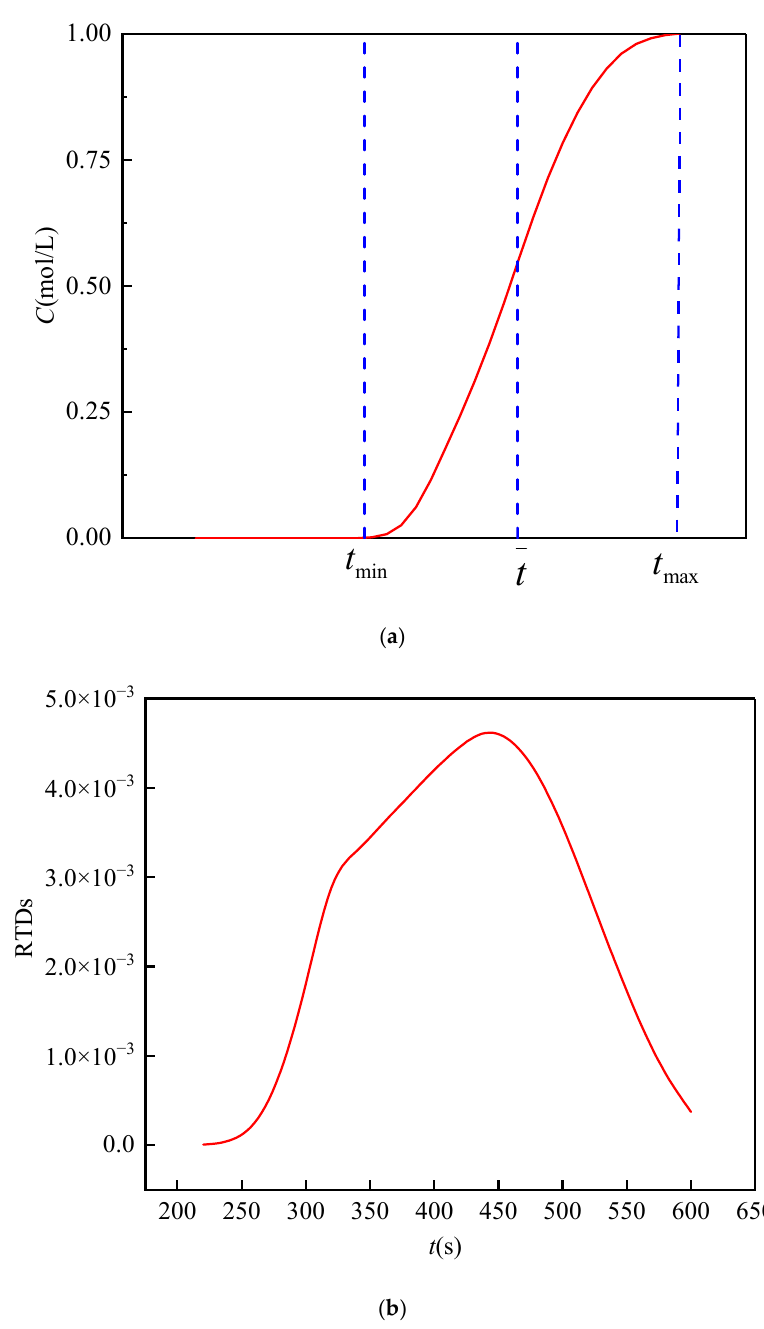
Figure 5. ( a ) The breakthrough curve; ( b ) the residence time distribution curve. The time variance s 2 and time skewness sk t of the residence time distribution curve is calculated on the basis of average Figure 6 shows the breakthrough curve and average time of the solute transport from different fractal dimensions and the standard deviation of aperture. The average arrival time of solute transport increases with the growth of the fractal dimension and standard deviation of aperture. This is because the increase in fracture roughness makes the flow velocity slow and then leads to an increase in the average time of solute transport. As shown in Figure 7a, the average time increases nonlinearly with the increase of fractal dimension. The relationship between the average time and fractal dimension can be ap- proximated by a power function as below: